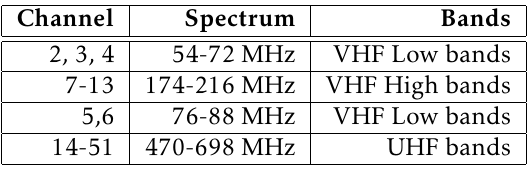
Table 1. TVWS frequency bands [2]